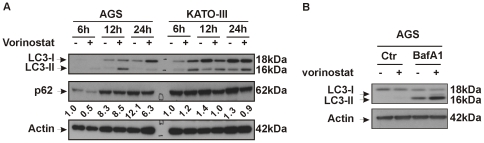
Autophagy induction by vorinostat treatment in gastric cancer cells.(A) AGS and KATO-III were treated with 5 µM vorinostat for the indicated time points. Protein levels of LC3 and p62 were analyzed by immunoblot analysis. Actin was used as a loading control. p62 levels were measured by densitometric analysis of the western blots and compared to actin levels. p62 levels of untreated AGS and KATOIII cells were considered as 1. (B) AGS cells were treated for 12 h with 5 µM vorinostat with or without 50 nM bafilomycin A1 (BafA1). Cell lysates were analyzed by immunoblot analysis for LC3 and actin.